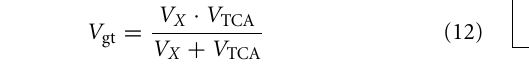
FIGURE 5 | Plot of the hyperbolic relationship between V X and V TCA for a constant composite flux value V gt (Eq. 12) .The knowledge of V gt alone only allows the calculation of V TCA under an assumption for the value of V X . However, the magnitude of the assumed V X flux can have a strong impact on the estimated V TCA .When assuming V X (cid:29) V TCA , we have V TCA = V gt . If V X is almost equal to V TCA , we obtain V TCA ∼= 2 · V gt